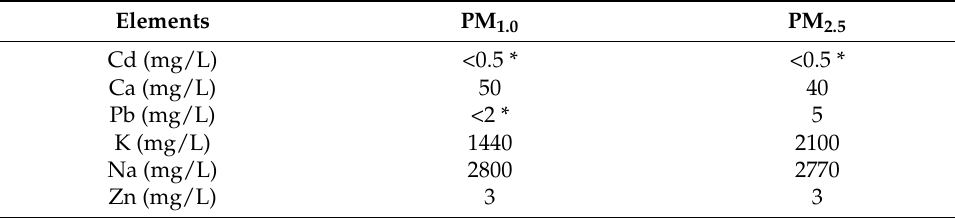
Table 1. Comparison of the elemental composition. Estimated method detection limit (EMDL) indicates the lowest possible concentration that can be detected. Estimated limit of quantitation (ELOQ) is an indication of a high probability of the element in the sample [23,24]. Legend: * means based on EMDL. Elements PM 1.0